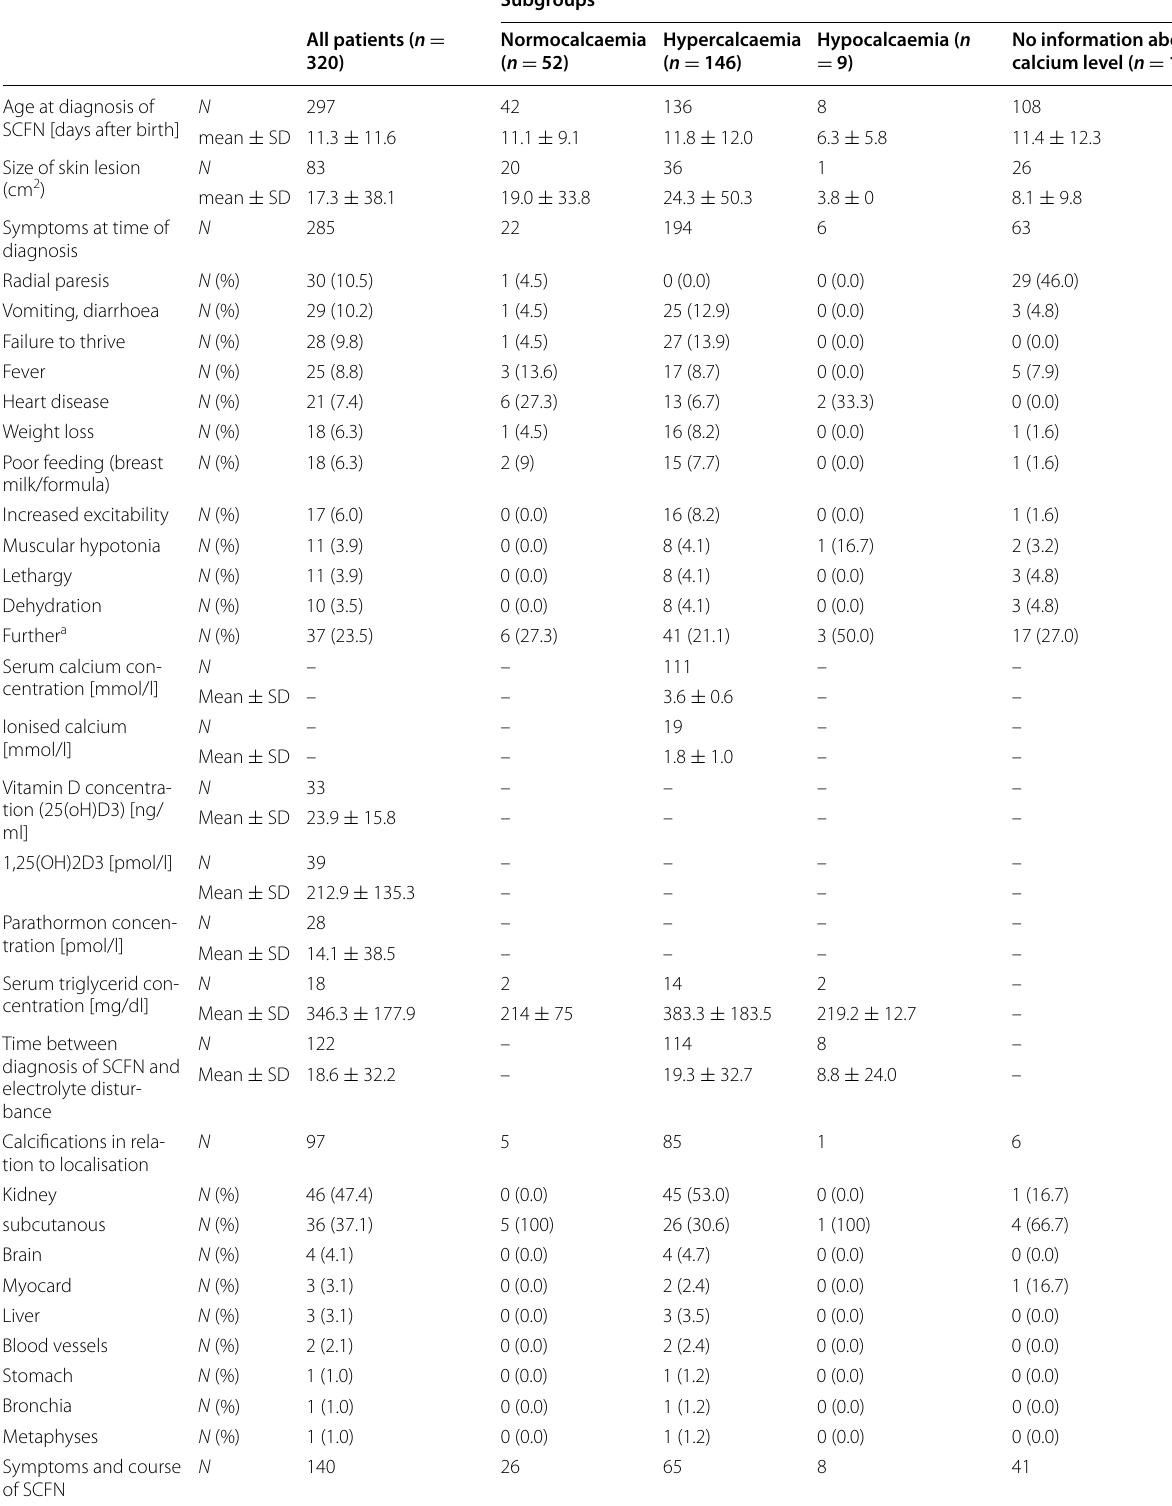
Table 1 Characteristics of SCFN in newborns